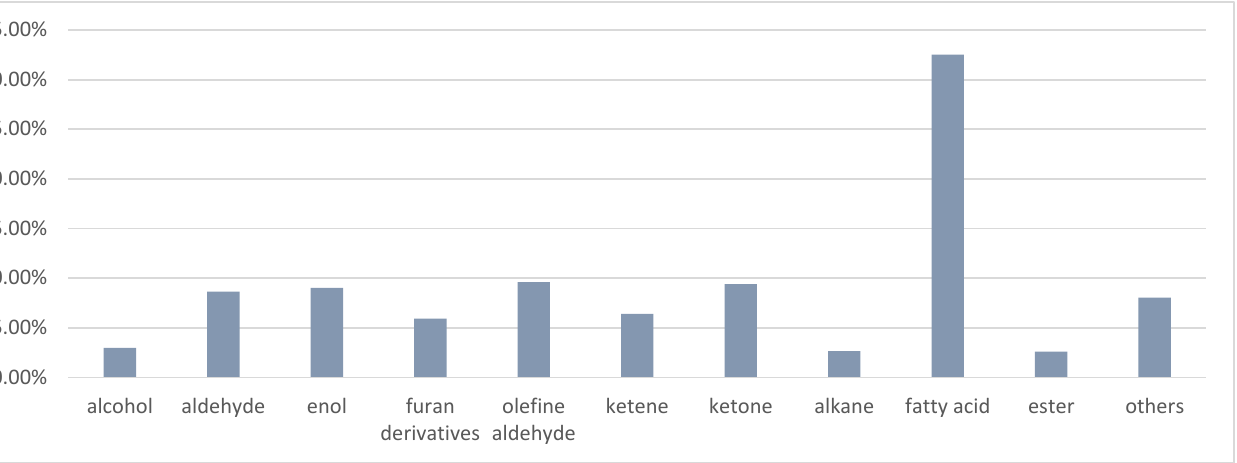
Figure 5. The percentage composition of chemical composition classes distilled from S. rhombifolia .